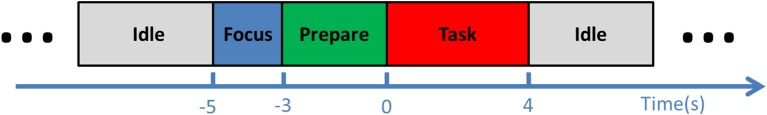
Experimental procedure. Each trial began with an idle phase, followed by a 2-s focus phase and a 3-s preparation phase. In the consequential task phase, the subject was instructed to perform ballistic or repetitive imagination of dorsiflexion.